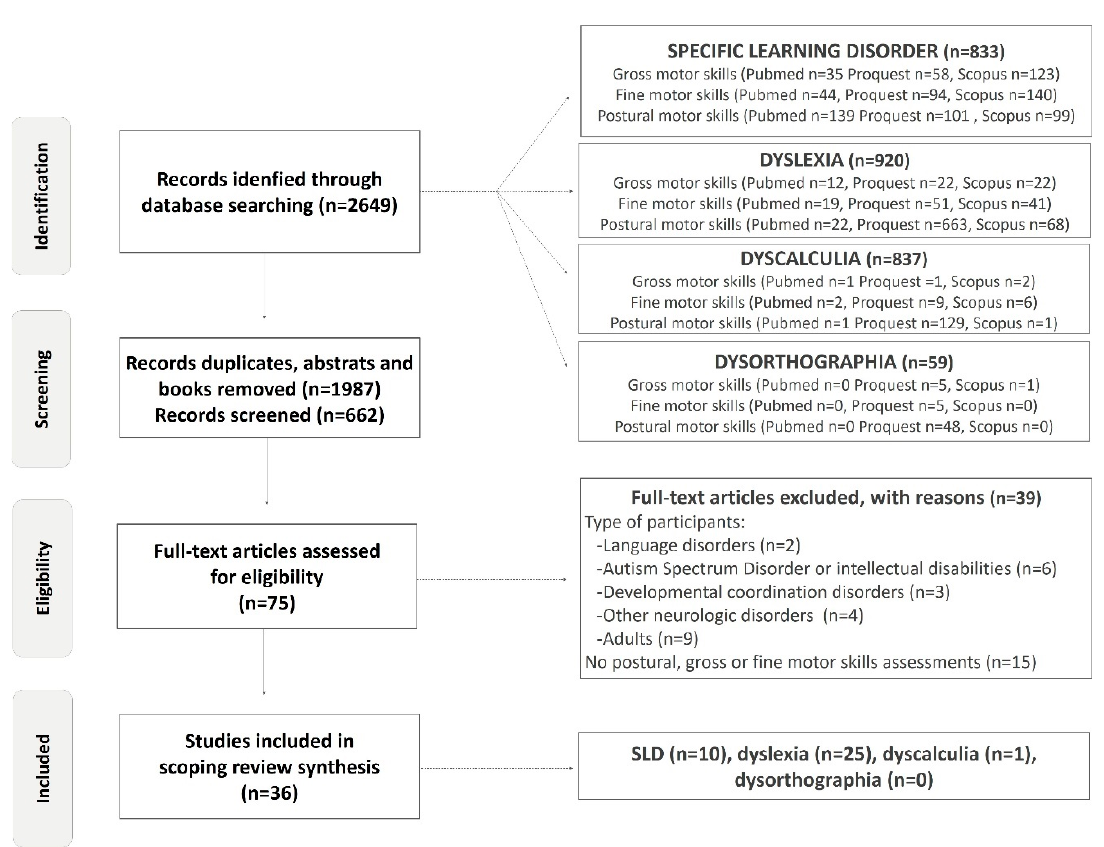
Figure 1. Flow diagram of included studies.